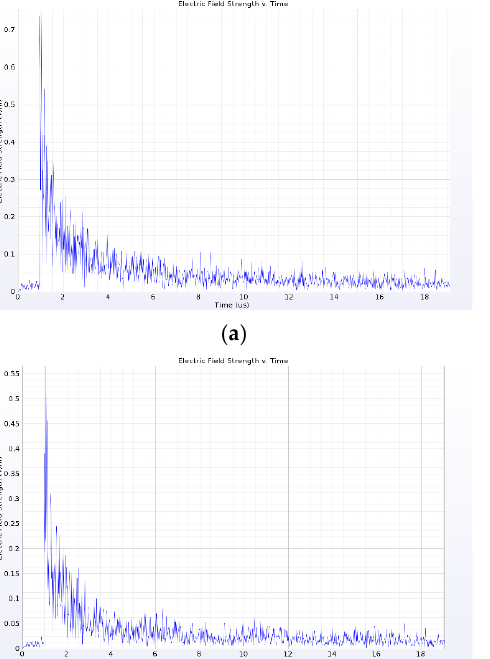
Figure 5. Location distribution of source and point sensors around current transformer .